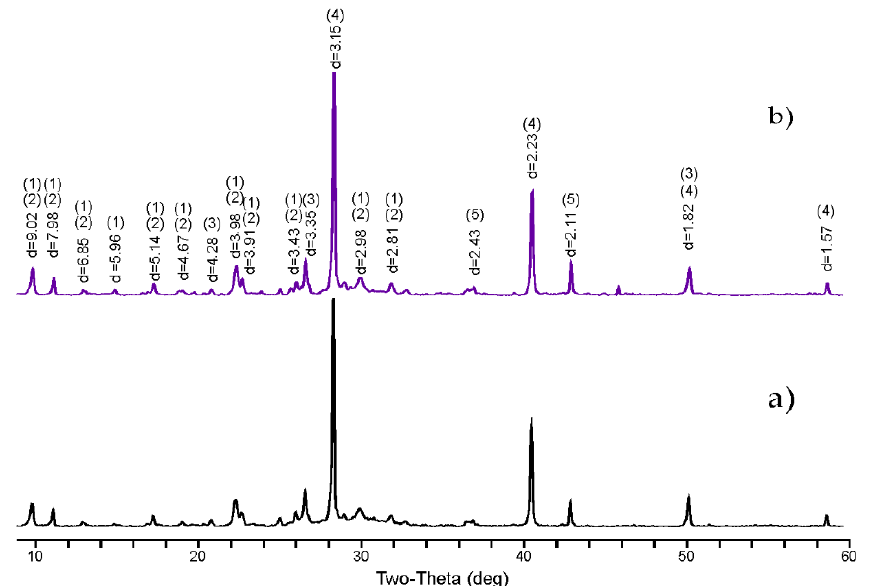
Figure 5. X-ray diffraction patterns of the ( a ) MPP-Z compound, including ( b ) after irradiation up to 10 8 Gy. 1–(Na, K, Ca) 5 Al 6 Si 30 O 72 ·18H 2 O (clinoptilolite-Na); 2–Ca 3.6 K 0.8 Al 8.8 Si 27.4 O 72 ·26.1H 2 O (heulanditea); 3–SiO 2 (quartz); 4–KCl (sylvite); 5–MgO (pereclase).